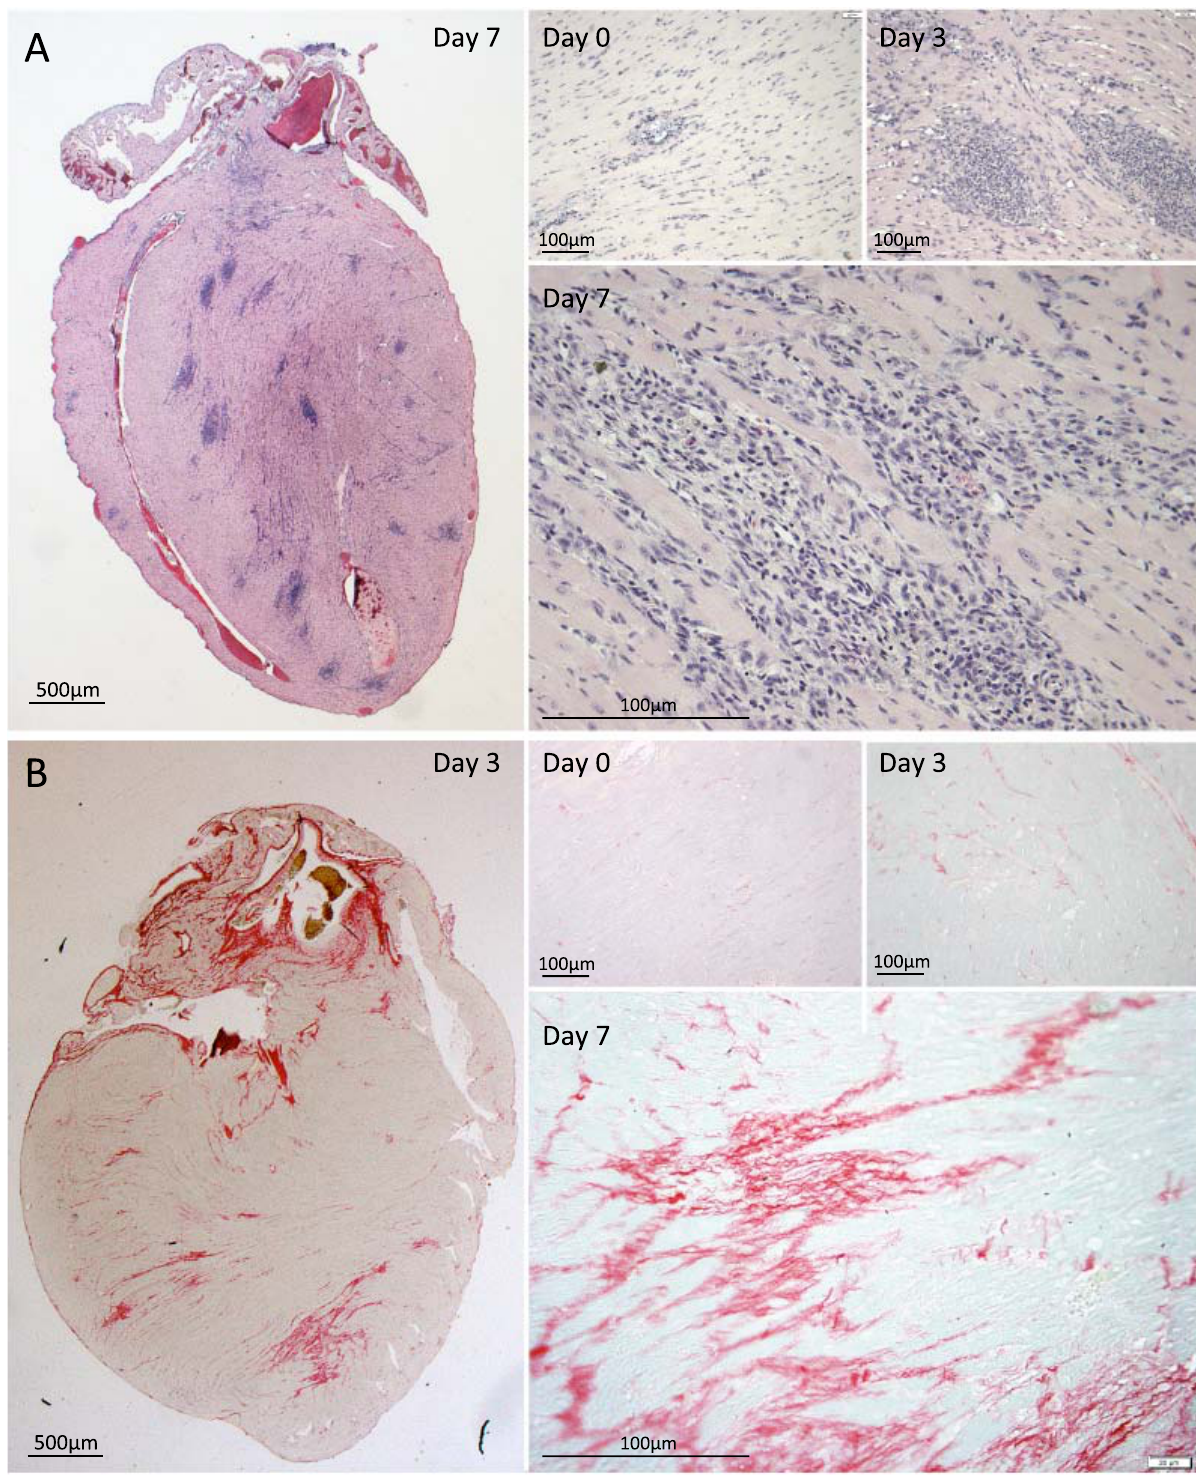
Figure 6. Immune cell infiltration and collagen deposition following antimicrobial therapy. BALB/c mice were infected with S. pneumoniae and beginning at 30 h treated with ampicillin for rescue. A) Representative H&E stained cross sections of hearts from BALB/c mouse at time when ampicillin treatment was initiated as well as 3 and 7 days post-infection. Note that former microlesion sites are now characterized by robust immune cell infiltration. B) Heart sections were also stained with Picrosirius Red to visualize collagen deposition.